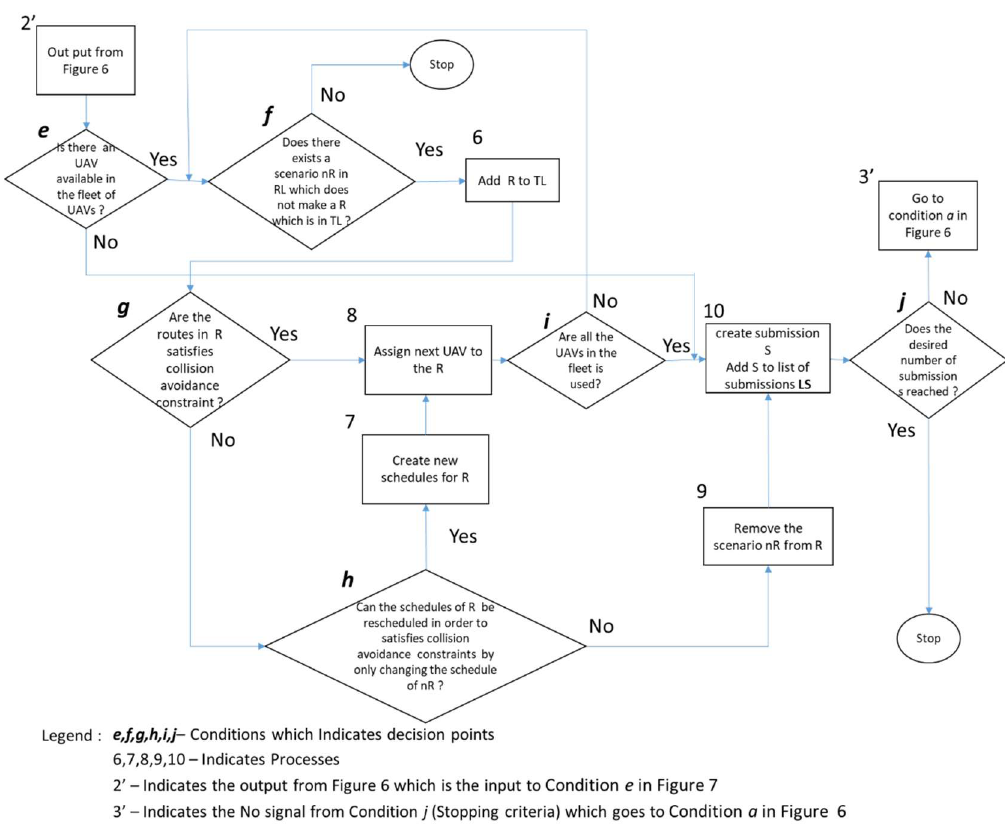
Figure 7. The heuristic to create sub-missions with collision avoidance for a cluster in an FTW.